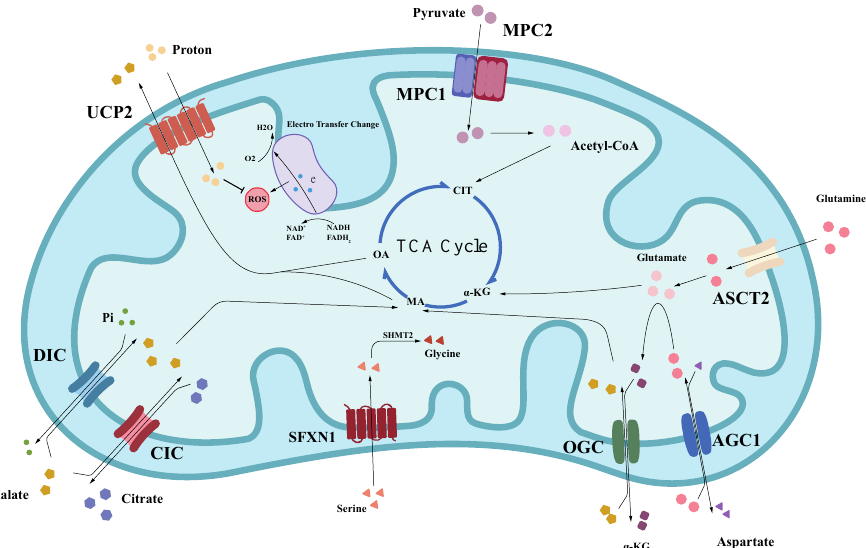
Figure 3. The transporters located in the IMM are ideal targets for anticancer drugs. The transporters located in the inner membrane of mitochondria act as the essential hub connecting the mitochon- drial matrix with the cytoplasmic matrix. Targeting transporters with abnormal expression in tumor cells to play an anticancer role has achieved the expected results in both in vitro and in vivo exper- iments. (ASCT2, alanine/serine/cysteine transporter 2; α - KG, α -ketoglutaric acid; AGC1, aspar- tate/glutamate carrier 1; CIT, citrate; MA, malic acid; OA, oxaloacetic acid; CIC, citrate carrier; DIC, dicarboxylate carrier; FAD + , flavin adenine dinucleotide; FADH 2 , dihydroflavine-adenine dinucle- otide; MPC, mitochondrial pyruvate carrier; NAD + , nicotinamide adenine dinucleotide; NADH, nic- otinamide adenine dinucleotide; OGC, oxoglutarate carrier; ROS, reactive oxygen species; SHMT2, hydroxymethyltransferase 2; SFXN1, sideroflexins 1; UCP2, uncoupling protein 2). 4.4. Others Han et al. revealed that SLC1A5 (ASCT2) transports glutamine to the mitochondria and plays an important role in cancer metabolism [138]. SLC1A5 is involved in the regu- lation of many oncogenic signaling pathways. Studies have shown that STAT3 regulates MYC expression in acute myeloid leukemia (AML), thereby controlling SLC1A5 transcrip- tion and OXPHOS and promoting the survival of leukemia stem cells [139]. Other studies have shown that neural precursor cells inhibit autophagy and mitochondrial metabolism by downregulating Unc51-like kinase 1 (ULK1) or ASCT2, thereby inhibiting the growth and survival of pancreatic cancer cells [138]. In addition, SLC1A5 expression was posi- tively correlated with the number of tumor-infiltrating B cells, CD4 + T cells, CD8 + T cells, macrophages, neutrophils, and dendritic cells in HCC and low-grade glioma (LGG), indi- cating its role in regulating tumor immunity [140]. In conclusion, SLC1A5 is a key target for cancer therapy.